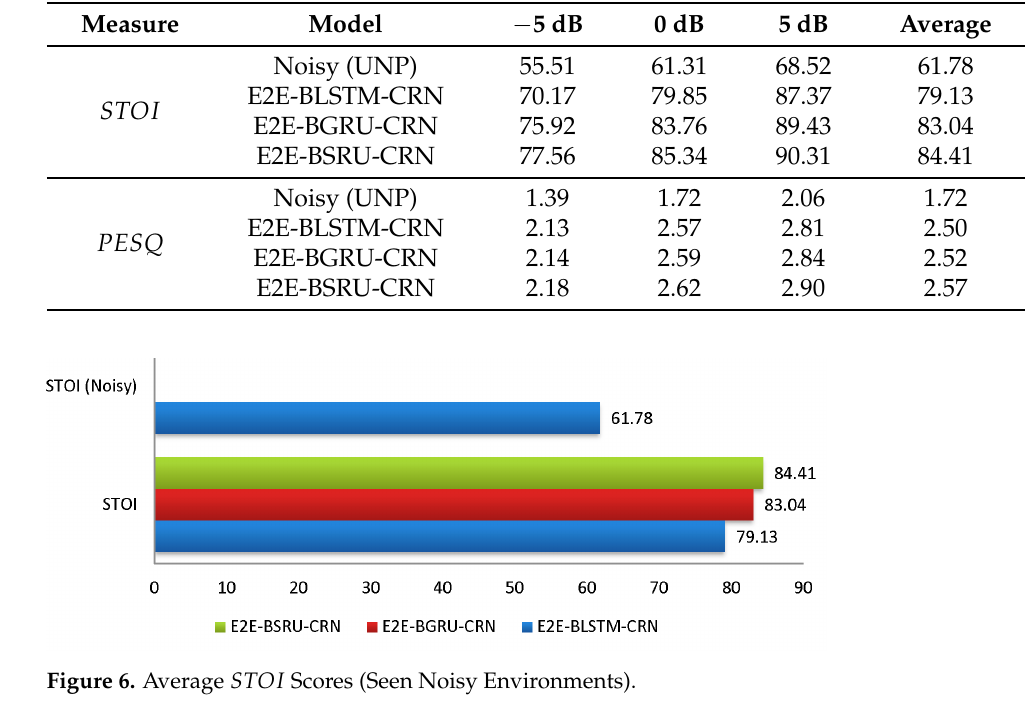
Table 3. Average STOI and PESQ scores in all Seen Noises.